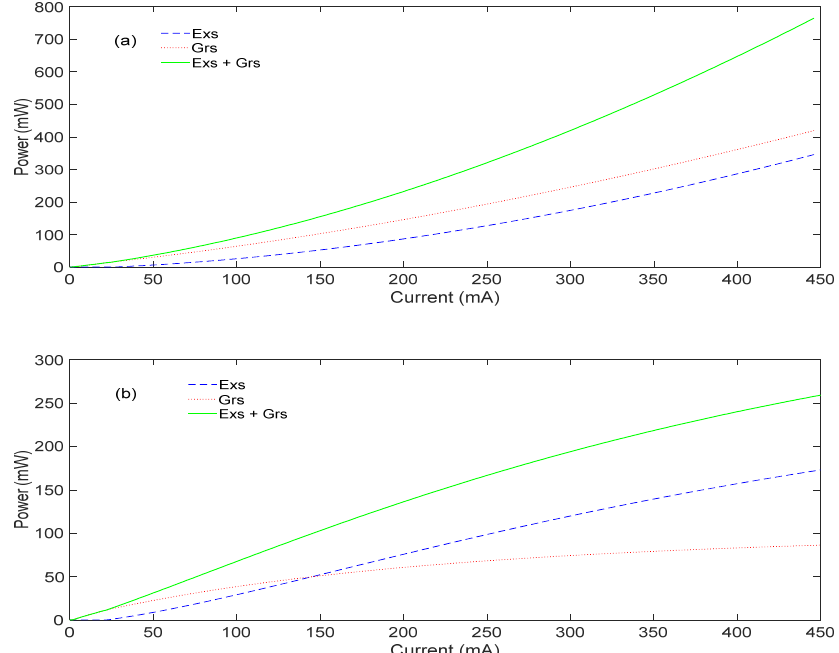
Figure 2. Output power vs. dc current without applying EOGB to the Exs, ( a ) ε Exs,Grs = 0 ( b ) ε Exs,Grs ≠ 0.